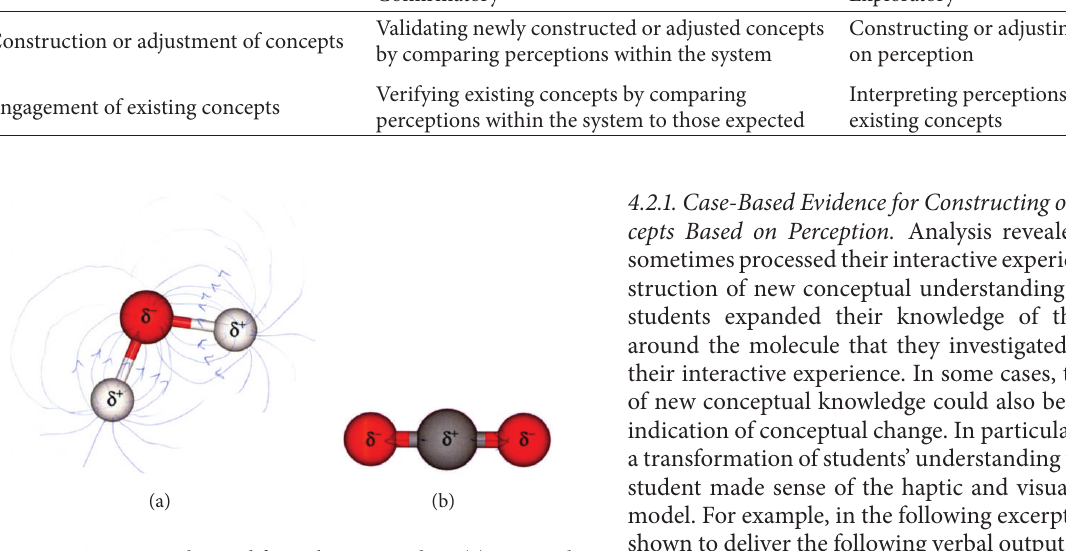
Figure 2: Two SGDs obtained from the written data. (a) accurately represents the overall shape of the electric field around an H 2 O molecule. However, the electric field that would be exhibited by the CO 2 molecular charge distribution is not depicted in diagram (b). The two arrows inserted erroneously indicate that the charges point- ing in opposite directions “cancel” each other out so that no electric field